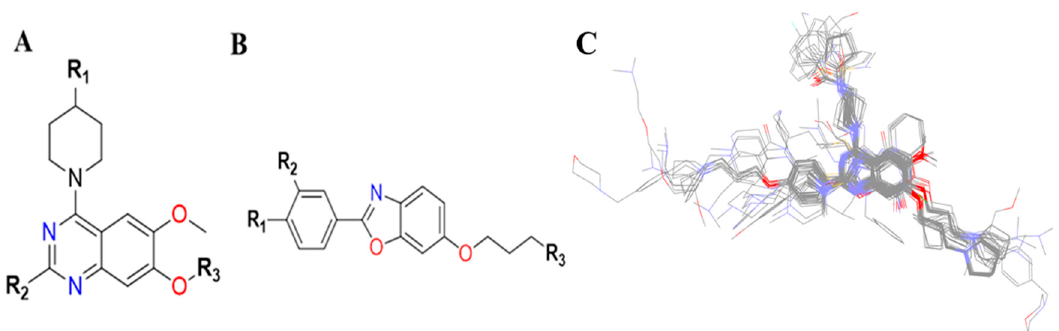
Figure 23. ( A ) Template quinazoline and ( B ) benzoxazole core of TLR7 inhibitors. ( C ) The alignment results of 54 TLR7 inhibitors was based on a field fit method.